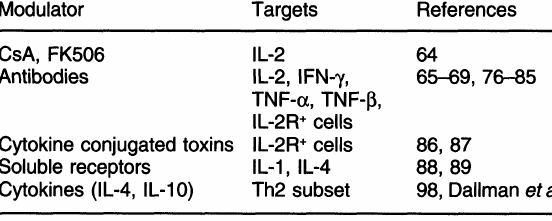
Table 3. Strategies interfering with cytokine